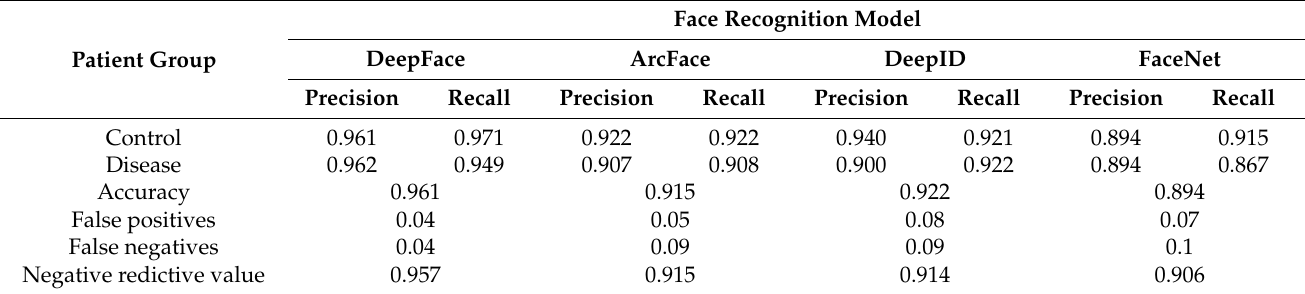
Table 3. Result of two-class classification for the 4 most accurate models.